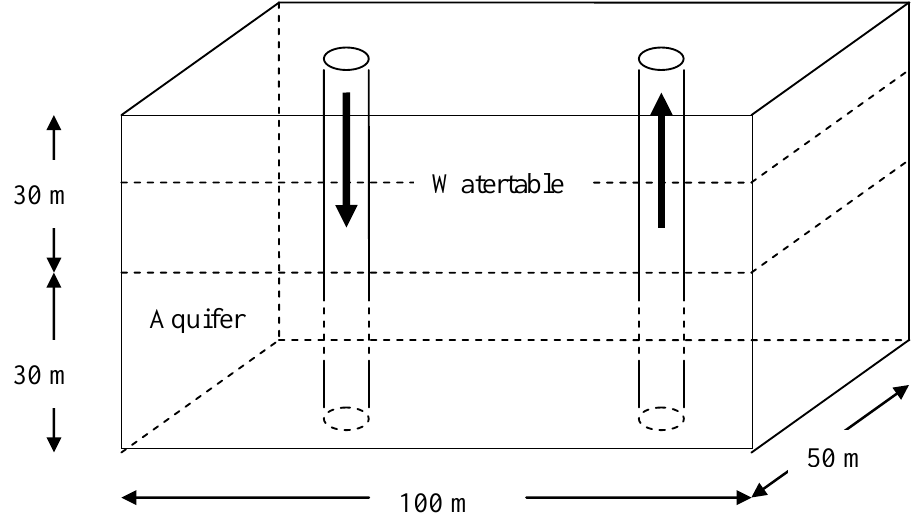
Figure 2. Schematic representation of simulation